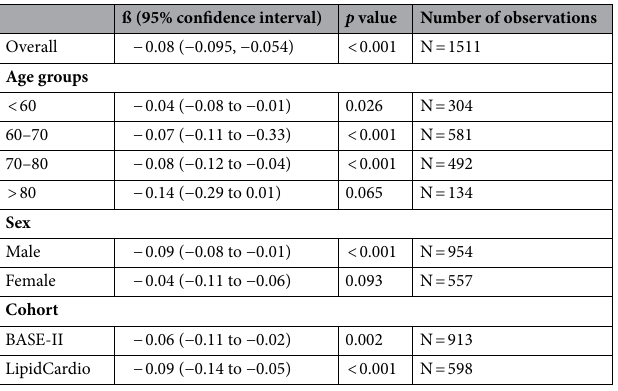
Table 4. Multivariable-adjusted coefficients (ß) for 5 kg increase in handgrip